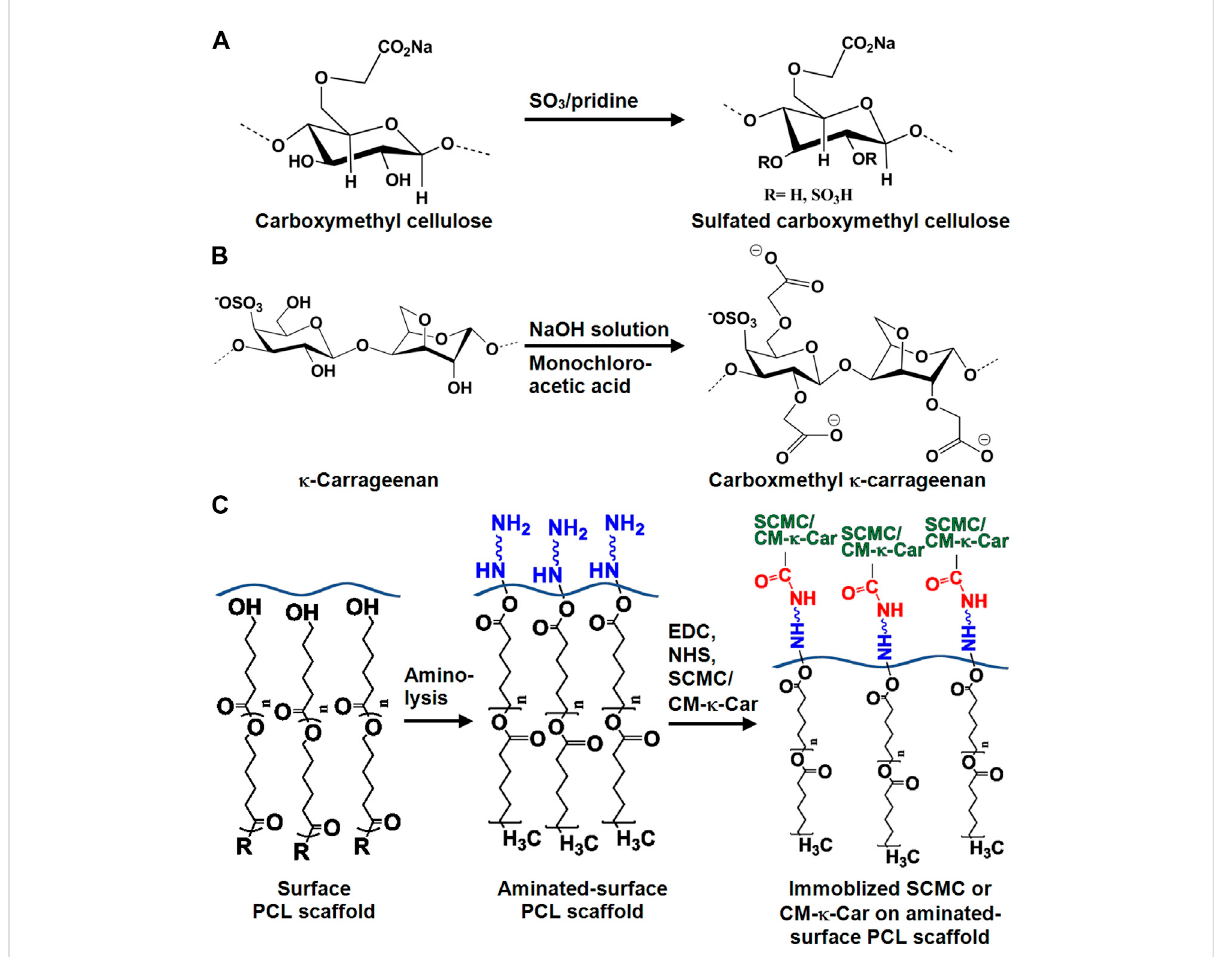
FIGURE 1 Chemical structure of SCMC and CM- l -Car surface-functionalized 3D-printed PCL scaffolds. (A) Chemical conversion of carboxymethyl cellulosetoSCMC. (B) Chemicalconversionof l -carrageenantoCM- l -Car. (C) Schematic illustrationofsurface-functionalization